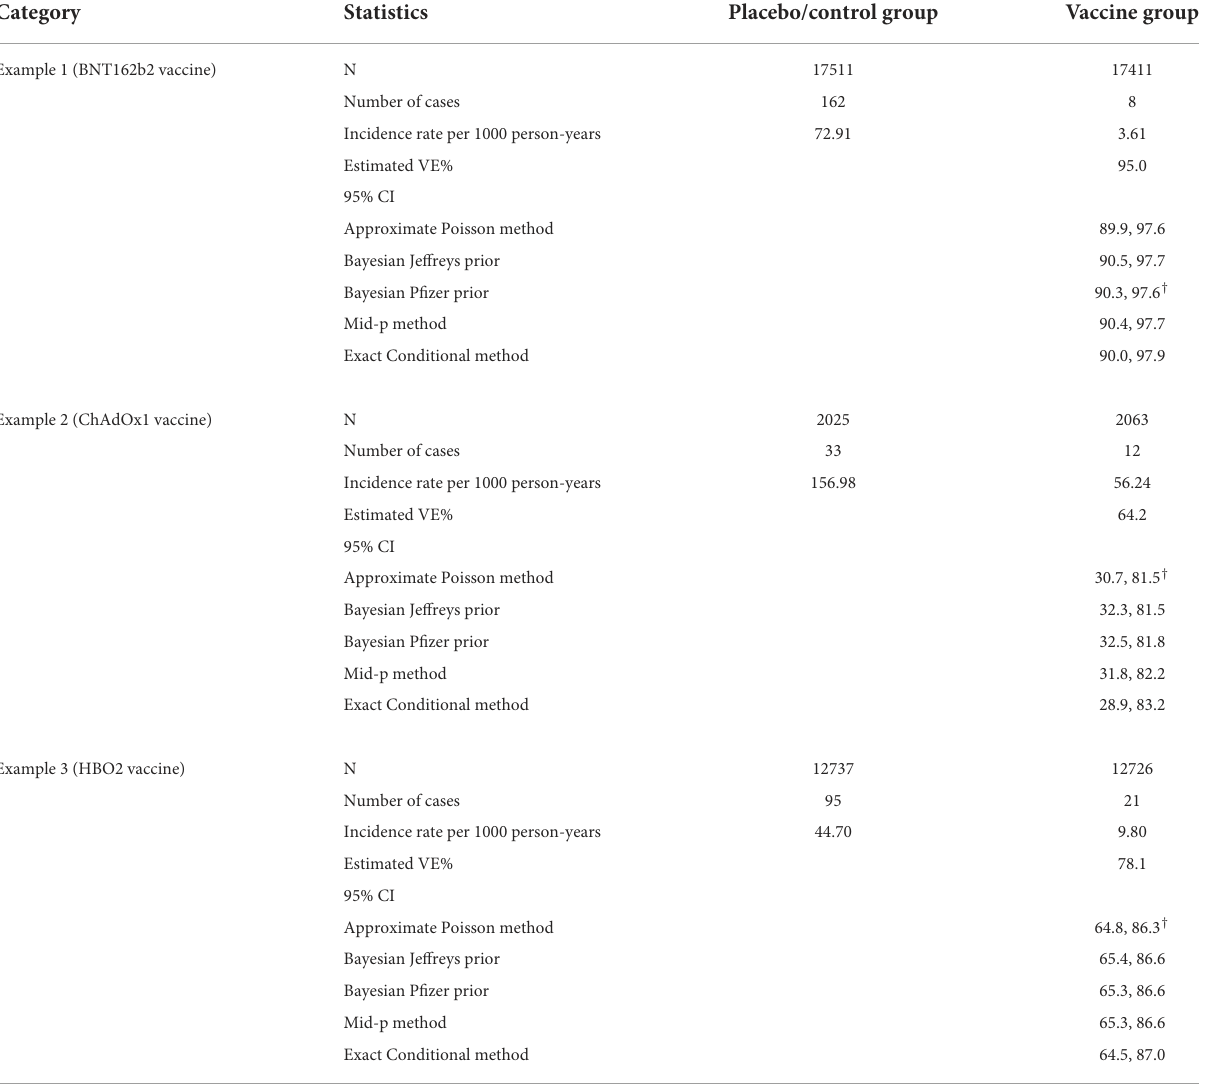
TABLE 2 COVID-19 vaccine efficacy against symptomatic Covid-19 in three case